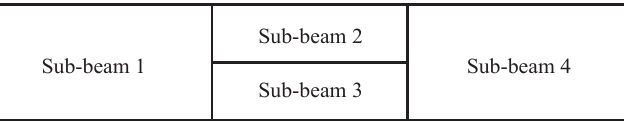
Fig. 2. Representation of beam with delamination into four